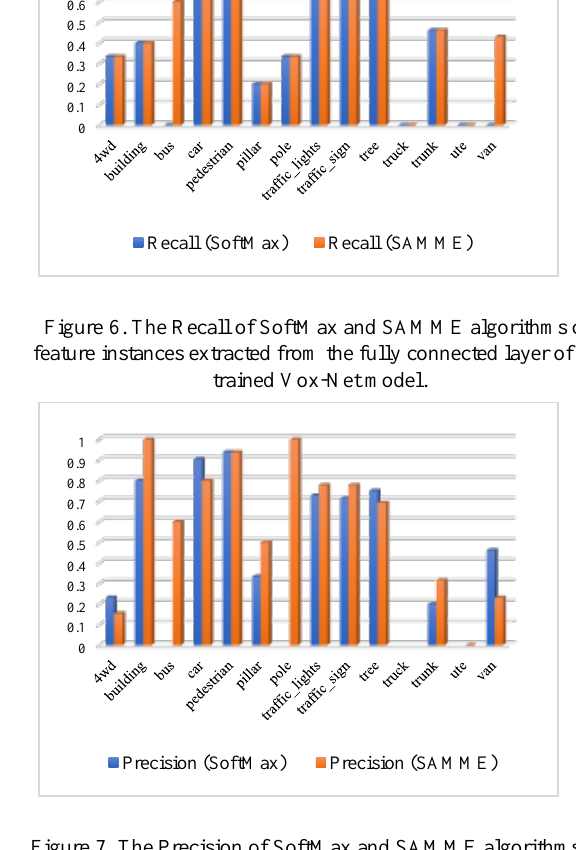
Figure 7. The Precision of SoftMax and SAMME algorithms on feature instances extracted from the fully connected layer of the trained Vox-Net